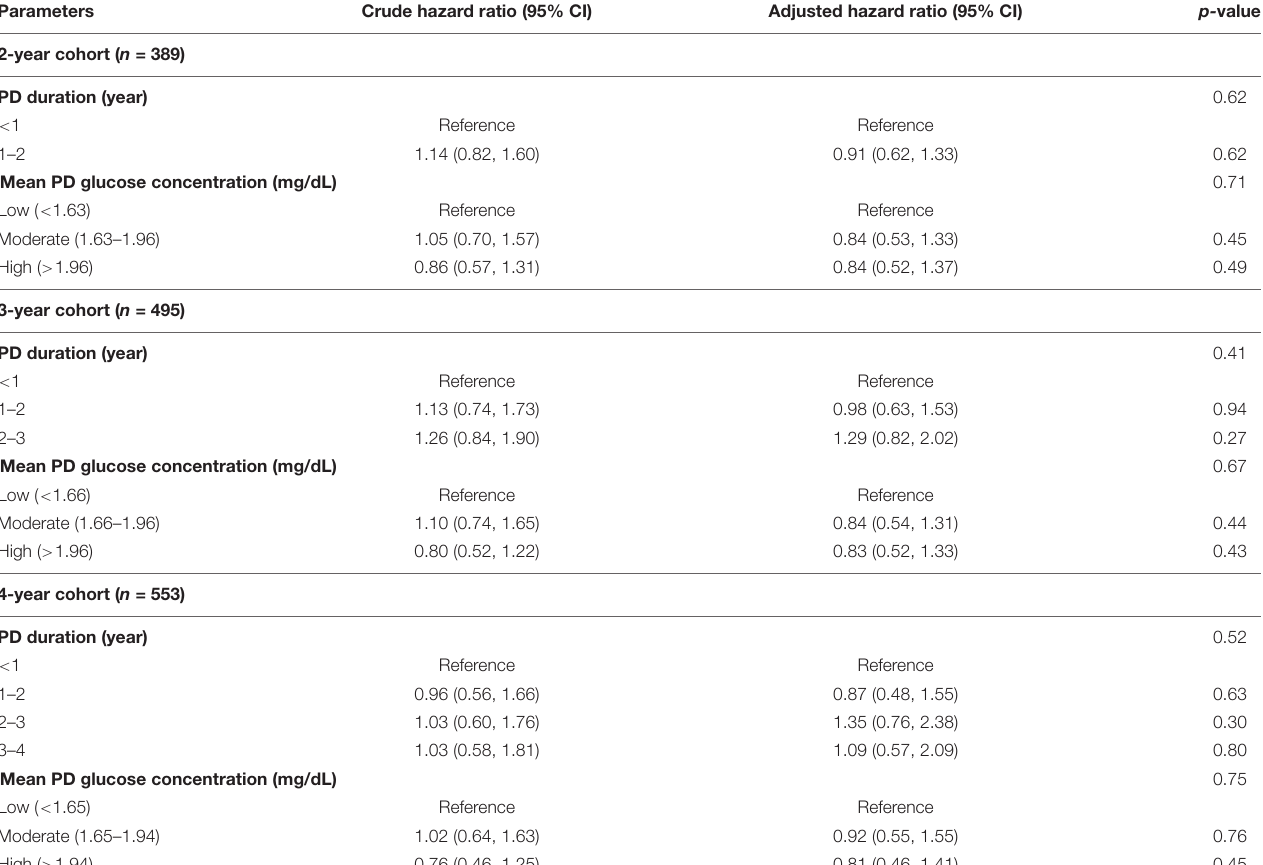
FIGURE 3 | Cumulative mortality proportion by mean glucose concentration of PD dialyzate. (A) Cumulative mortality proportion in the 2-year cohort; (B) cumulative mortality proportion in the 3-year cohort; (C) cumulative mortality proportion in the 4-year cohort. The Kaplan–Meier approach was used to estimate the mortality proportions with the differences of mortality proportion examined by the Wilcoxon test. A p -value < 0.05 was significant. TABLE 3 | Risk of mortality concerning PD exposure by different time-window cohorts by the cause-specific Cox regression model # .